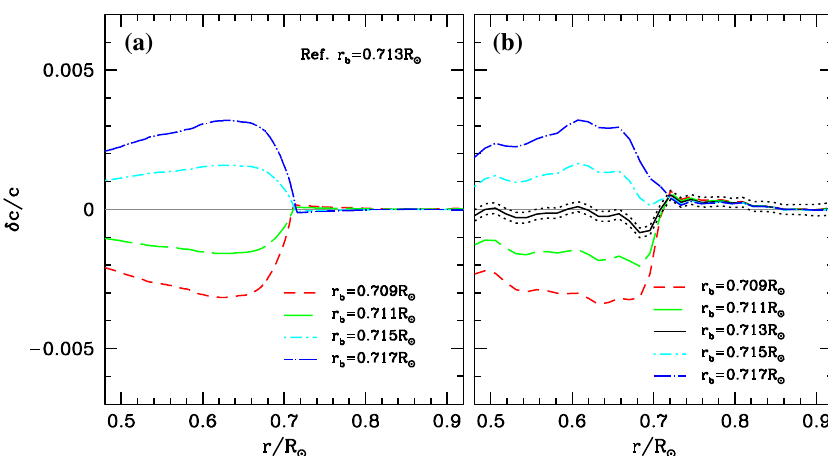
Fig. 17 a The relative sound-speed difference between a solar envelope model with a convection zone base r b at 0.713 R (cid:6) and other models with different values of r b . All other physics inputs to the models are identical. b The sound-speed difference between the Sun and the different models in a . The solar sound-speed results are from Basu et al. (2009). The dotted lines show the 2 σ uncertainties on the solar